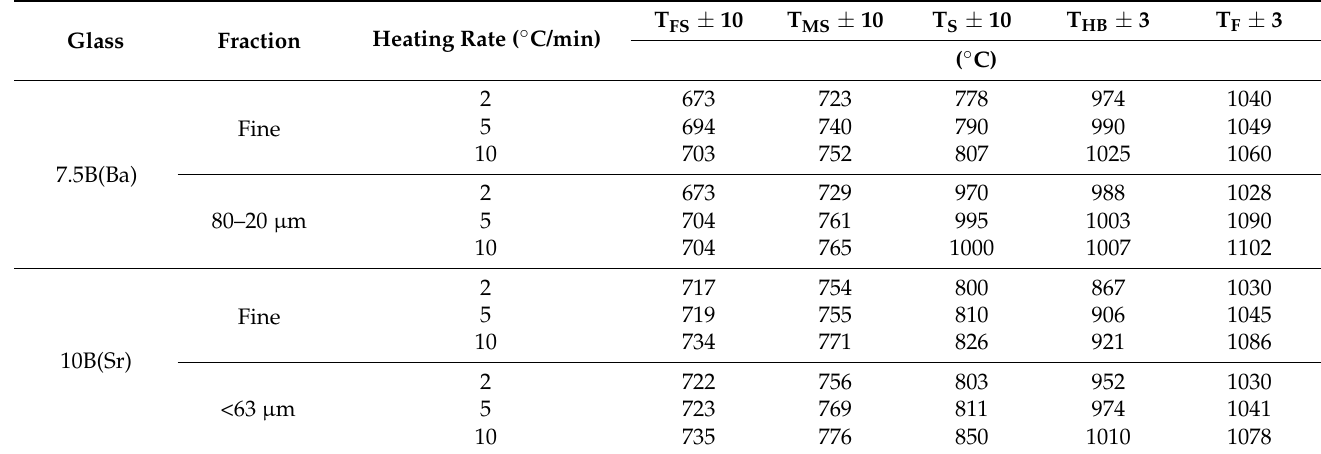
Figure 2. HSM curves for compositions ( a ) 7.5(Ba) and ( b ) 10B(Sr). Table 3. Characteristic temperatures from HSM curves.